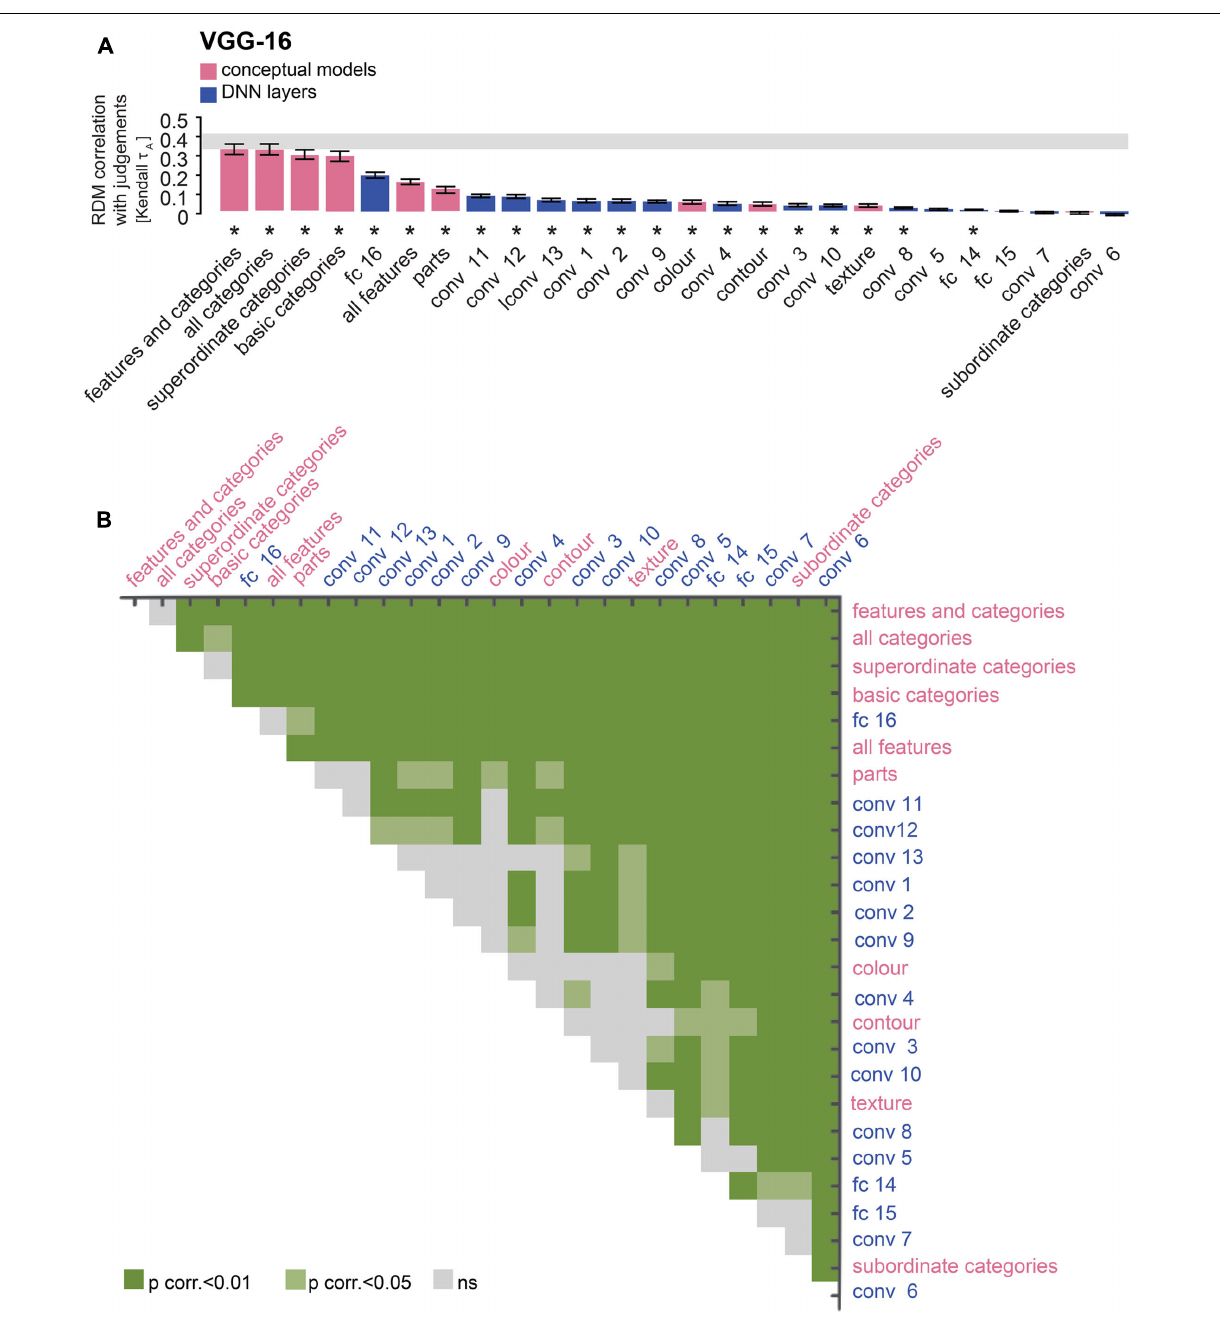
FIGURE 9 | Comparison of VGG-16 and conceptual models: the last layer outperforms almost all feature-based, but not categorical models. (A) Bars show the correlation between the similarity-judgment RDMs and each fitted VGG-16 layer RDM, as well as each fitted conceptual model. Noise ceiling and significant correlations are indicated using the conventions in Figure 4 . (B) Pairwise differences between model performance of fitted VGG-16 layer RDMs and conceptual models, using the same conventions as in Figure 4